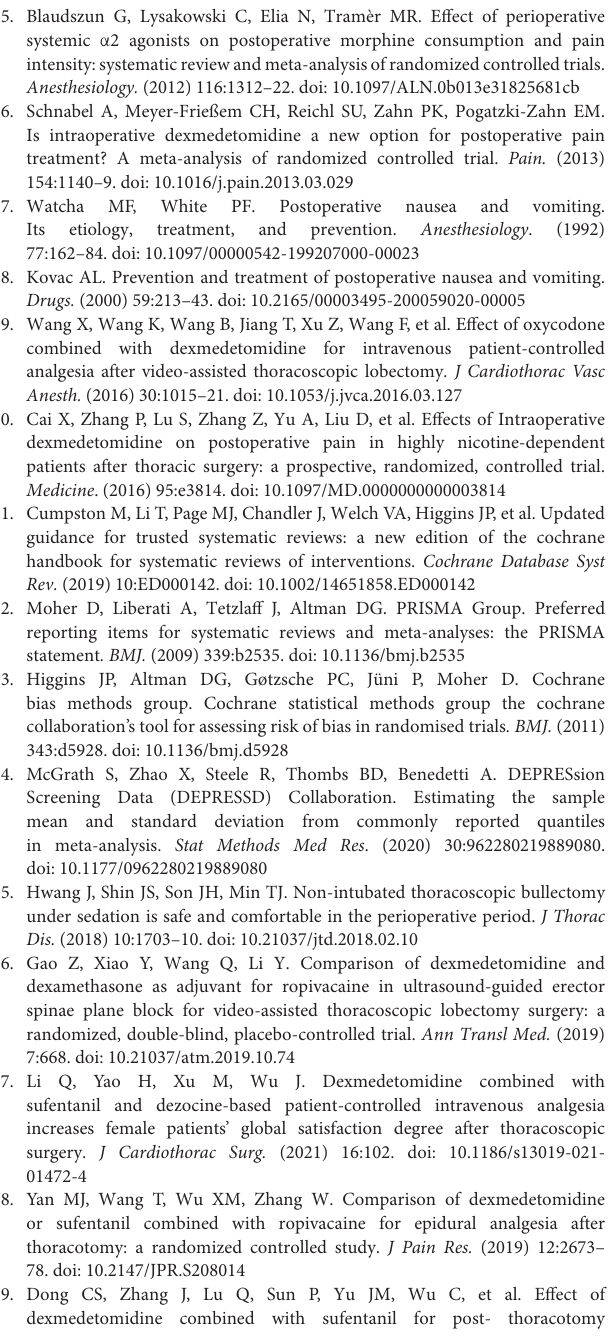
Supplementary Figure 1 | Publication bias. The publication bias of the effect of dexmedetomidine on PONV is relatively small. As noted in the figure, the left and right sides of the plot are basically symmetrical (A–D)